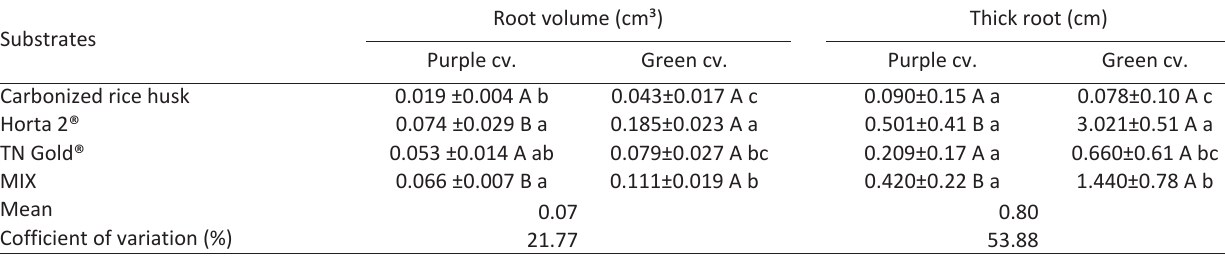
MIX= mixture composed of 40% Caborized rice husk, 40% Horta 2® and 20% TN Gold®. Data presented as mean ± standard deviation. Means followed by the same letter in the column did not differ significantly by the Tukey test (P≤0.05,